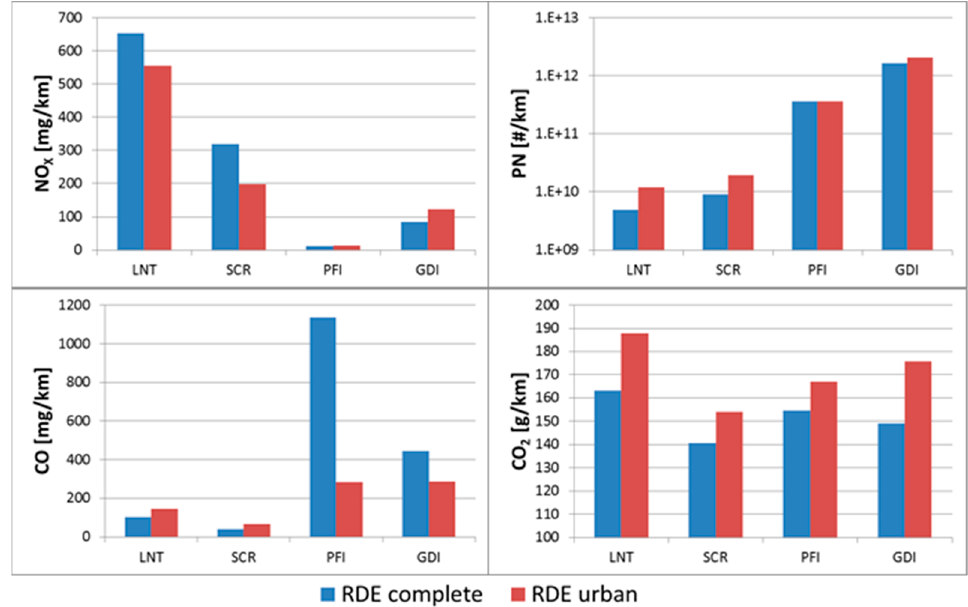
Figure 7. Average distance-specific emissions of NO X [mg / km], PN [# / km], CO [mg / km], and CO 2 [g / km] per after treatment technology (diesel vehicles) and injection type (gasoline vehicles) on the RDE complete and RDE urban tests.